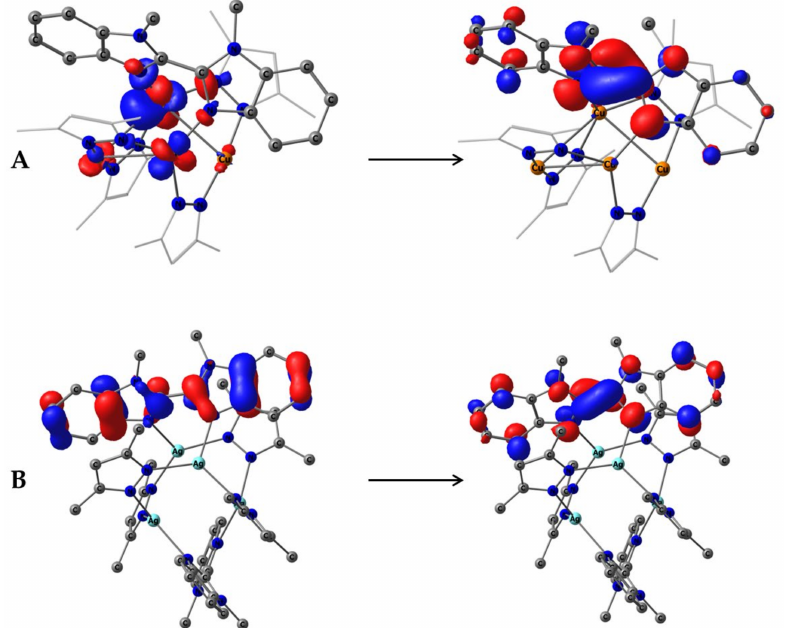
Figure 8. Natural transition orbitals HONTO ( Left ) and LUNTO ( Right ) for S 0 → S 1 excitation of 2 (A) and 4 (B) as isosurfaces at 0.05